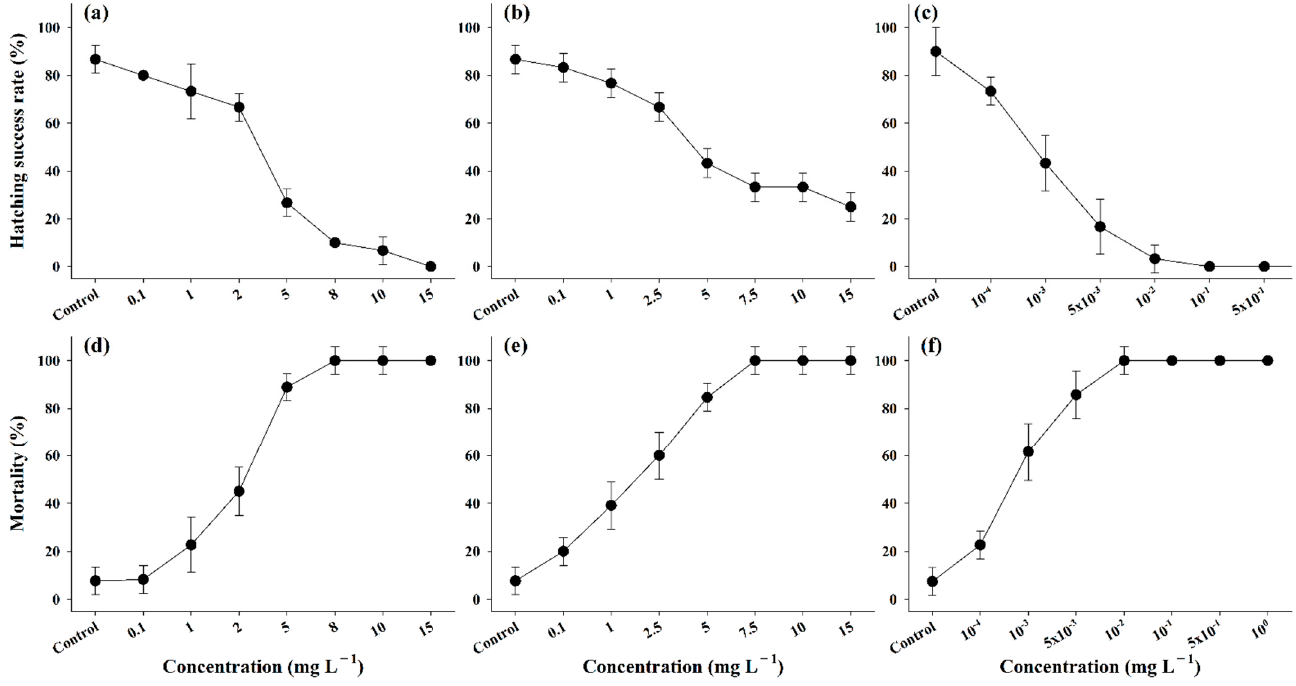
Figure 1. Egg-hatching success rate and nauplius mortality of Paracalanus parvus sl for three booster biocides ( a , d ): Diuron; ( b , e ): Irgarol 1051; ( c , f ): Sea-nine 211. Table 2. LC 50 values (LC 50 ± 95% CI) of Paracalanus parvus sl at 24 h for three booster biocides (Diuron, Irgarol 1051, and Sea-nine 211) and wastewater (WHPB and WHPB-MeOH) from high-pressure water blasting.